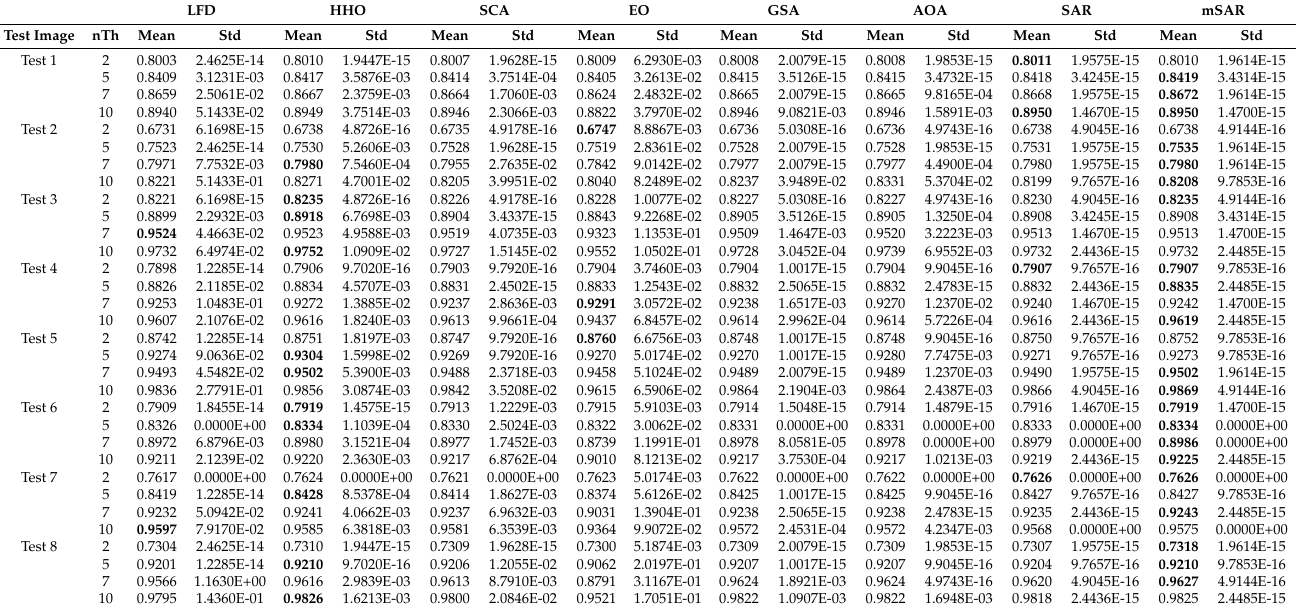
Table 10. mSAR Otsu in terms of SSIM values overall competed for algorithms.